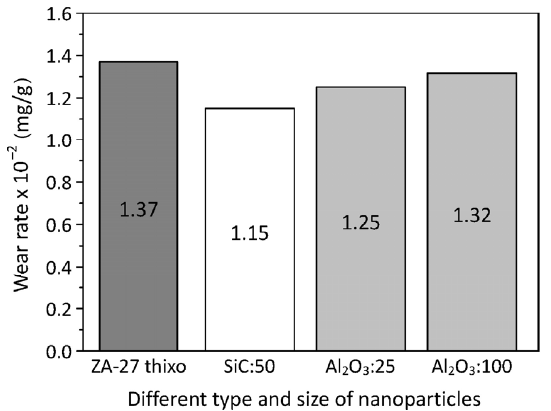
Fig. 4 Influences of the type and size of nanoparticles on the erosive wear rate of tested materials.